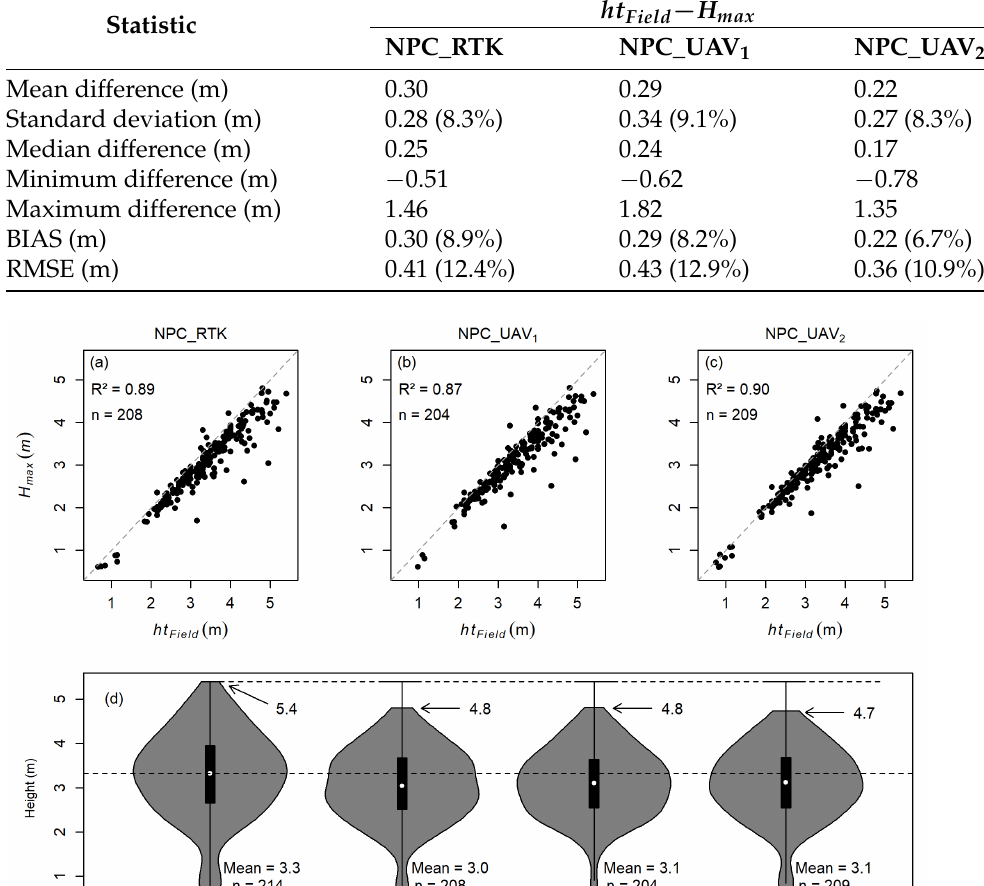
Table 4. Statistics of tree height estimates, considering each normalized point cloud (NPC) analyzed.